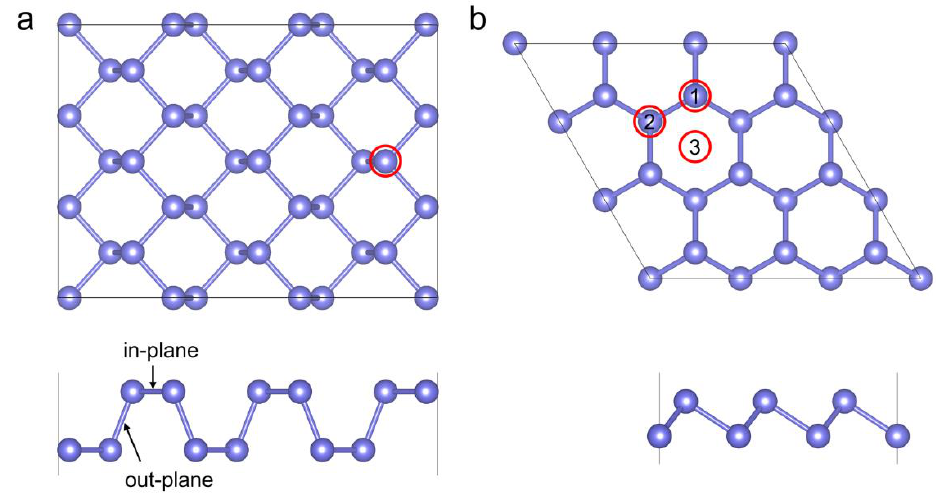
Figure 1. Atomic configurations of all group-VA 2D monolayers. ( a ) α and ( b ) β phase. Red circles represent the different adsorption sites for Cl atoms. Top panel—top view; bottom panel—side view. Table 1. Structural parameters of all group-VA 2D monolayers. a and b are the lattice constants, d is the thickness of the monolayer, and L denotes the bond lengths.